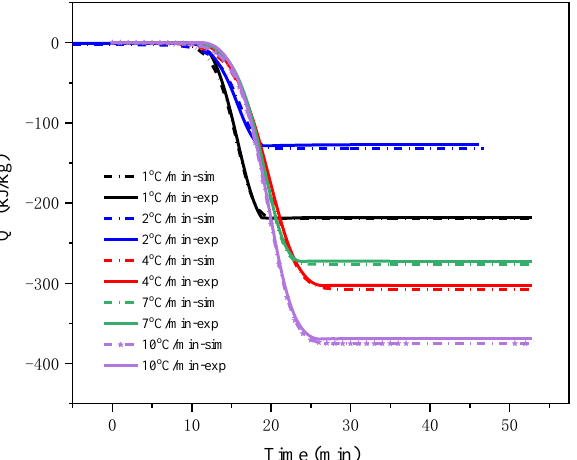
Figure 7. Evolution of heating production of LiTFSI-LiODFB electrolyte thermal decomposition reaction with time in experiment and simulation.